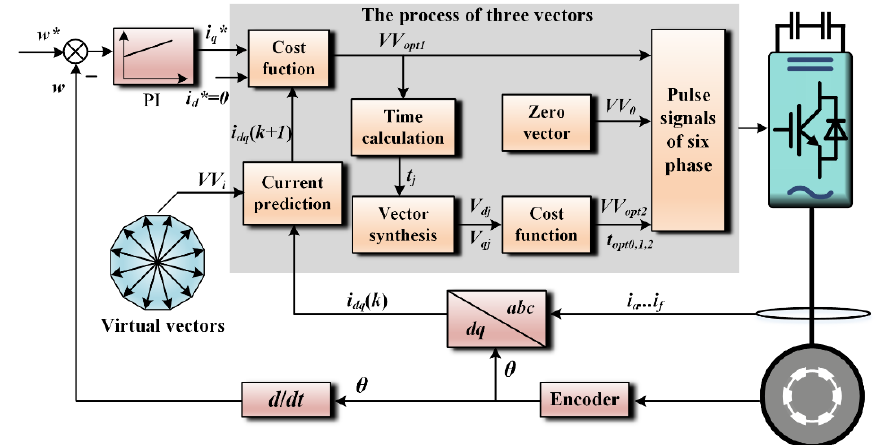
Figure 5. Control scheme of VV-MPC.